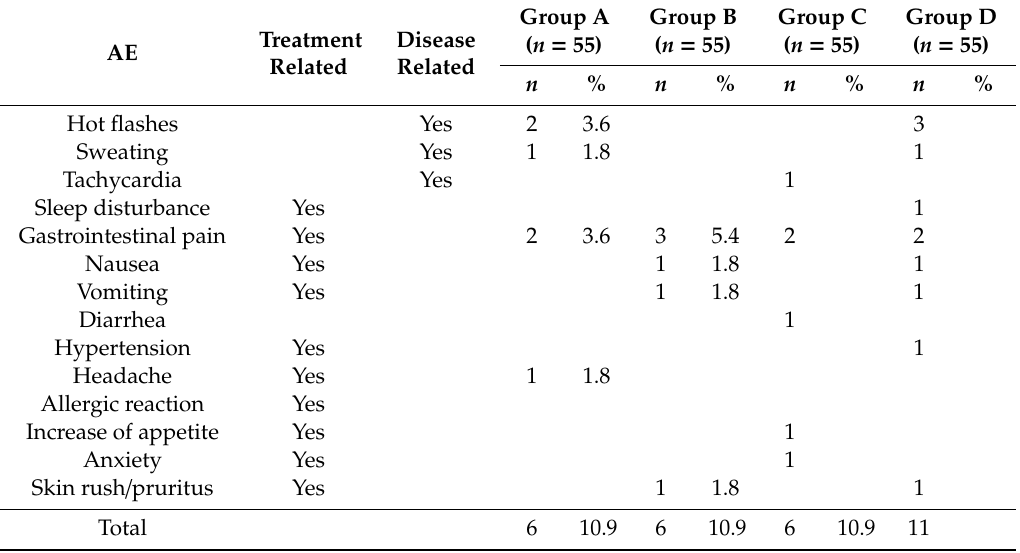
Table 4. Emergent adverse events observed in each treatment